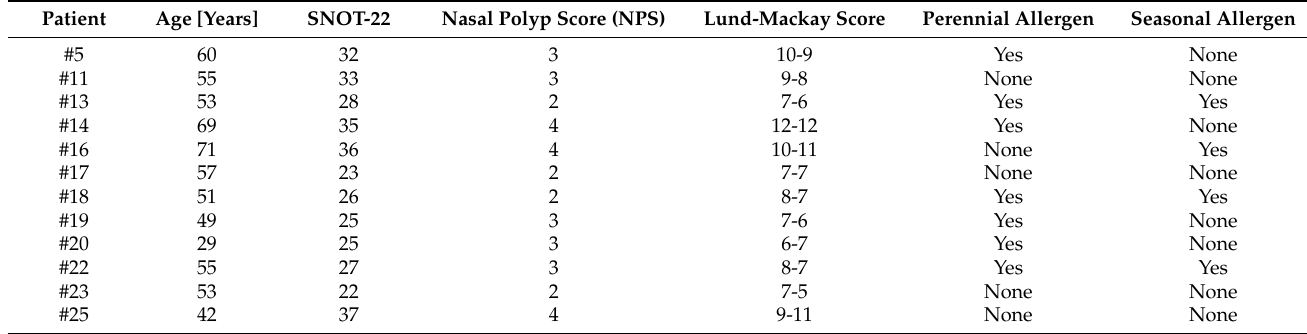
Table 1. Characteristics of enrolled